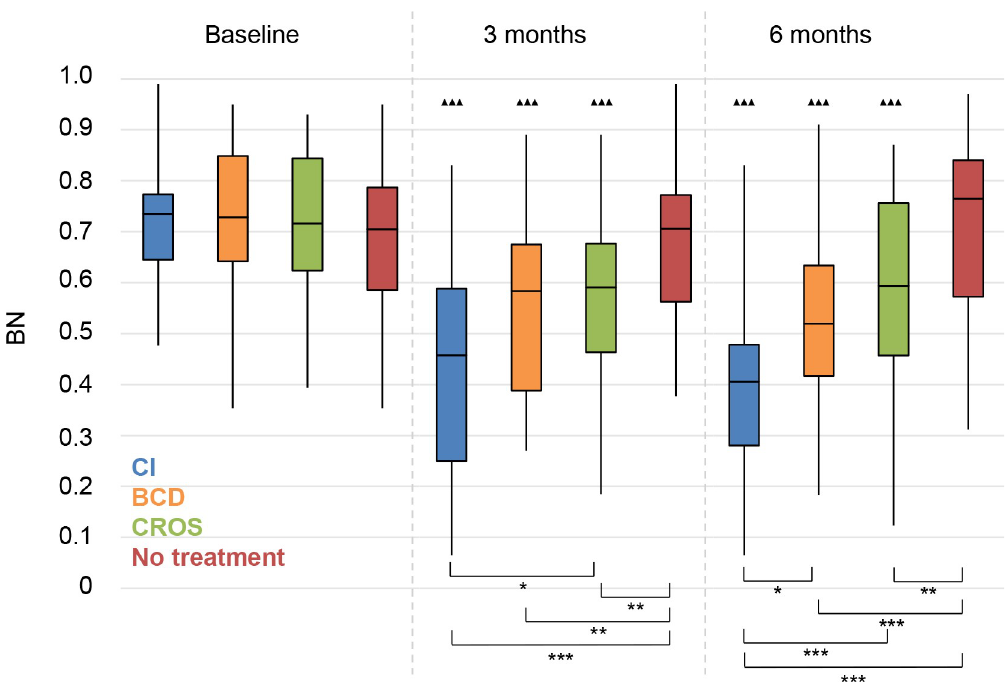
Fig 14. Abbreviated Profile for Hearing Aid Benefit questionnaire (APHAB). Background noise (BN). Statistical difference compared to baseline. ▲▲▲ = p < 0.001; ▲▲ = p < 0.01; ▲ = p < 0.05. Statistical difference compared to 3 months follow- up. ■■■ = p < 0.001; ■■ = p < 0.01; ■ = p < 0.05. Statistical difference between groups at same follow-up moment. ��� = p < 0.001; �� = p < 0.01; � = p <